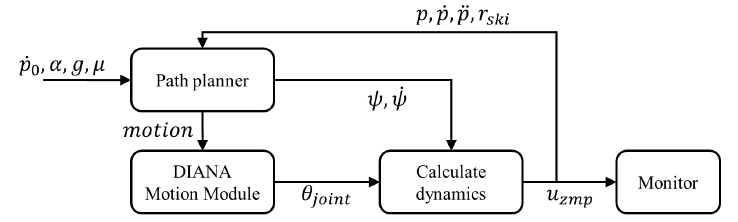
Figure 12. Simulation